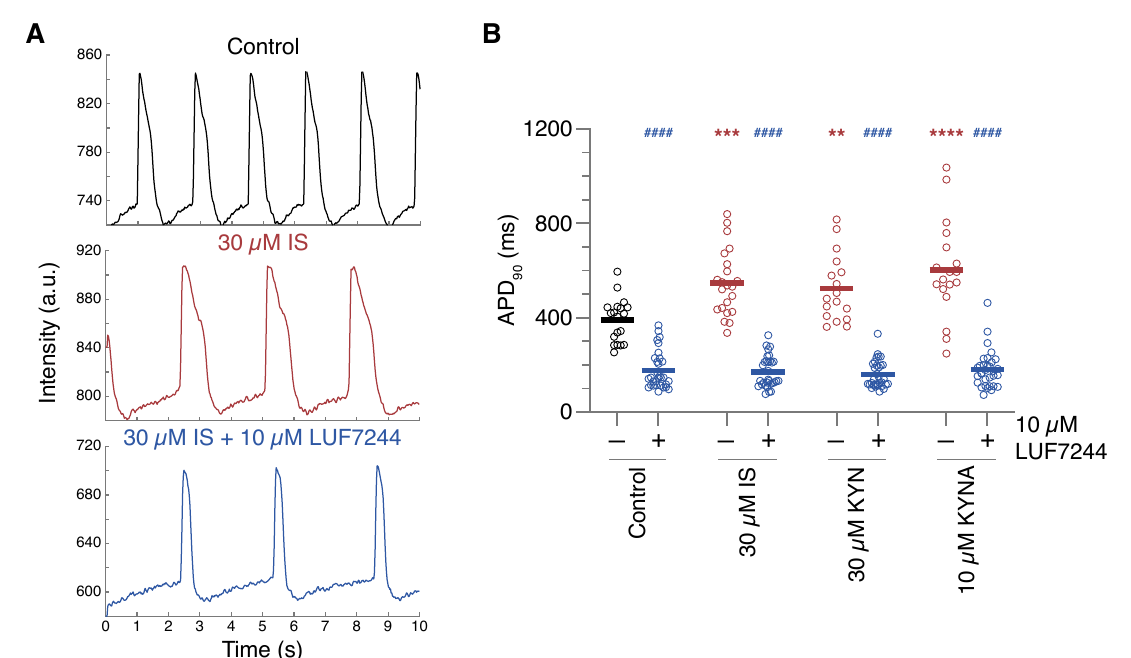
Figure 4. Reversal of uremic toxin-induced action potential prolongation by LUF7244. Action potential duration (APD) was measured in spontaneously beating cells, using a voltage sensitive dye. hiPSC-CMs were exposed to high concentrations of indoxyl sulfate (IS), kynurenine (KYN), and kynurenic acid (KYNA), for 48 h, followed by an additional 24 h of uremic toxin exposure in the absence or presence of LUF7244 (indicated by – and + respectively). ( A ) Example traces of APD measurements in control, 30 µ M IS, and 30 µ M IS + 10 µ M LUF7244. ( B ) Quantification of APD measurements. Data are shown as the means with individual measurements, and quantified APDs were corrected for beating rate. Measurements were obtained in four independent differentiations of hiPSC-CMs with the number of cells = 17–32. ** p < 0.01, *** p < 0.001, **** p < 0.0001 compared to control without LUF7244. #### p < 0.0001 compared to control with